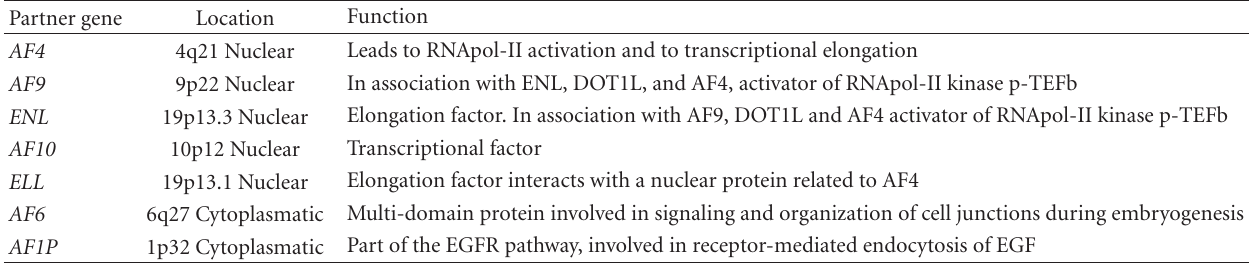
Table 1: The most common fusion partner genes of MLL : locations and